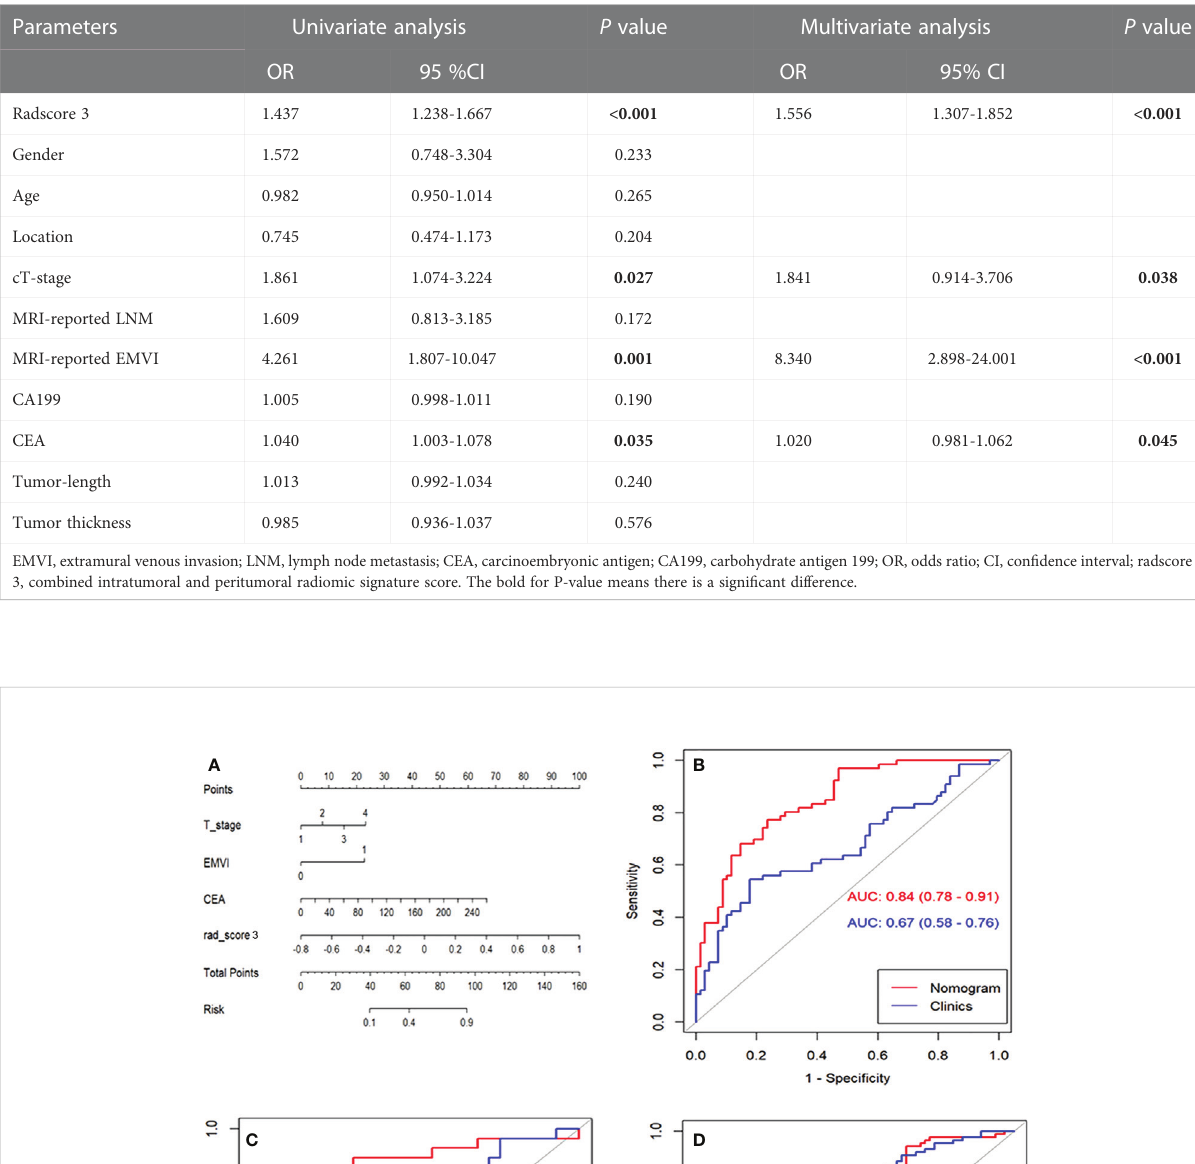
TABLE 2 Univariate and multivariate logistic regression analysis for clinical characteristics and radiomic signature.